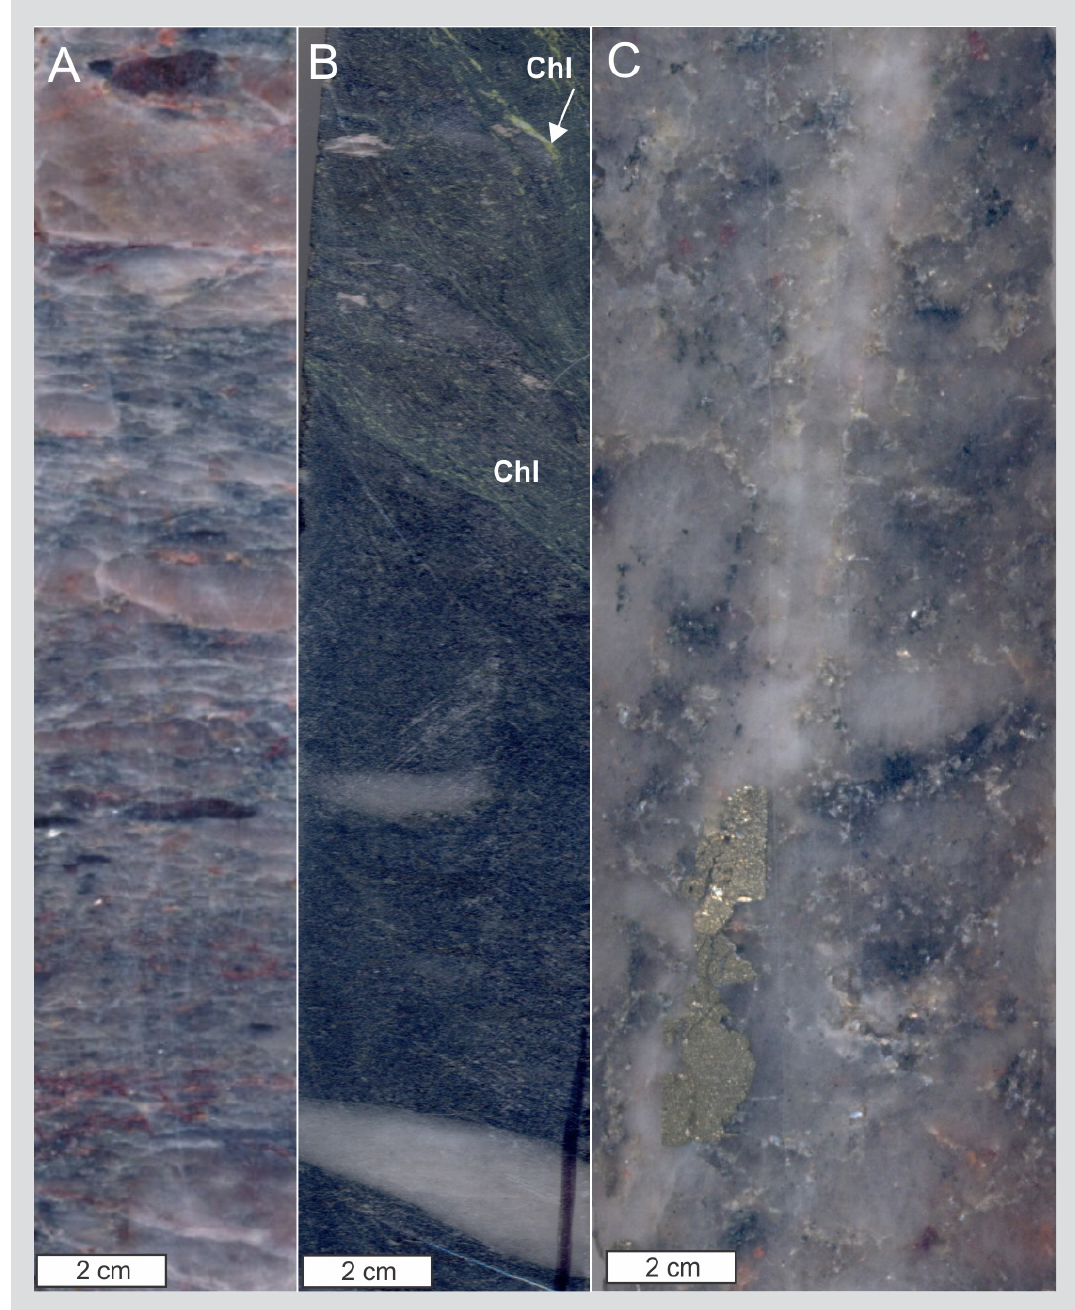
Figure 6 - (A) Deformed metaconglomerate showing orientation of matrix and elongation of clasts. (B) Mylonitic metaconglomerate with metamorphic/hydrothermal (?) chlorite (Chl). (C) Quartz-pyrite veinlet crosscutting metaconglomerate.